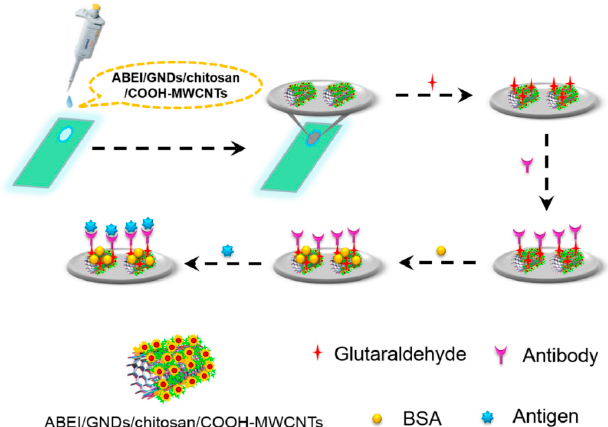
Figure 4. Schematic description for label-free N-terminal pro-brain natriuretic peptide (NT-proBNP) immunosensor based on ABEI/GNDs/chitosan/COOH-MWCNTs. Reproduced with permission from [50].